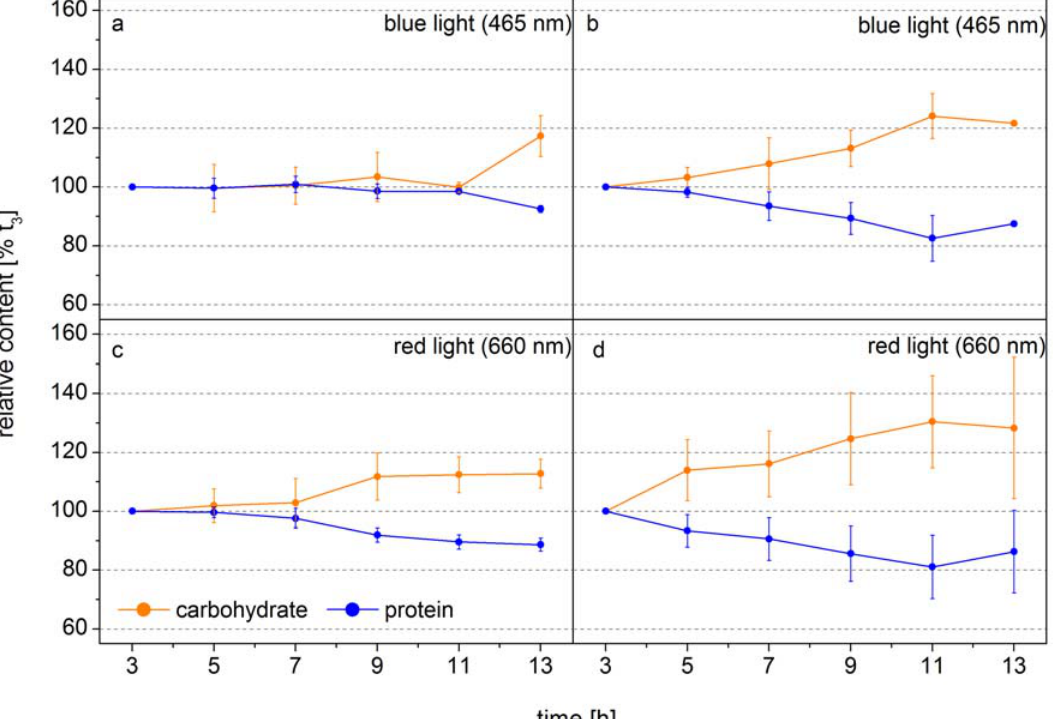
) and ( b ) 30 µmol Phar